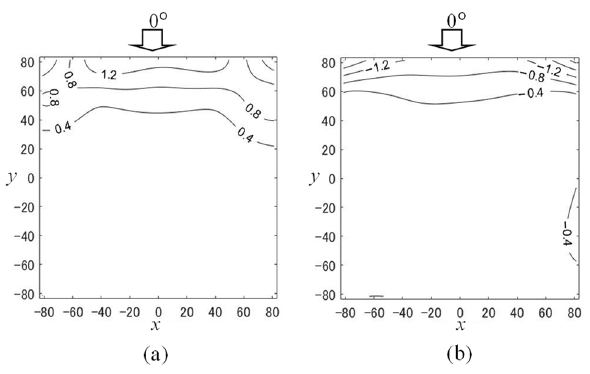
Figure 12. Contours of the maximum and minimum peak wind force coefficients at θ = 0°: ( a ) Maximum; ( b ) minimum.